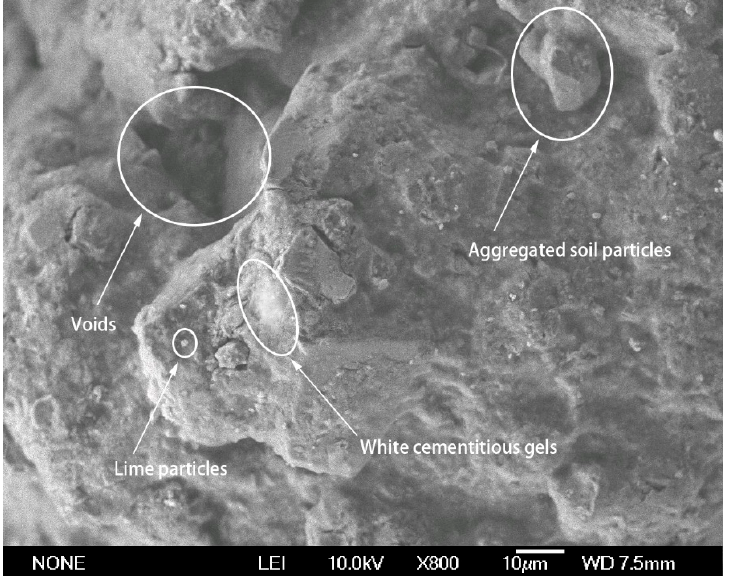
Figure 10. SEM micrograph showing white cementitious gels produced by the chemical reaction of soil and lime. and